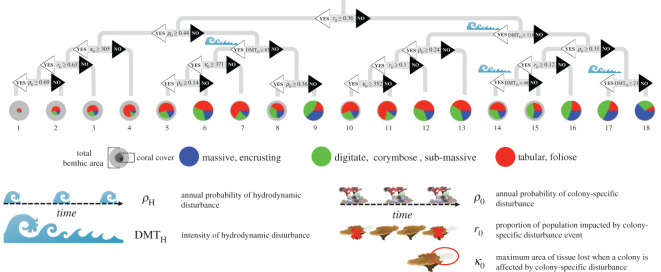
Summary of outputs from a multivariate regression tree analysis, summarizing the structuring of 100 000 simulations across ranges of five disturbance parameters. A total of 17 parameter conditions result in 18 stereotypical coral communities. Range of parameter values explored are presented in table 1. Each parameter condition presented here is hierarchical, structured as a decision tree with parameter inequality noted in the break, agreement with inequality labelled with a white arrow (and text ‘YES’, always linked to following tree to the left), and disagreement labelled with a black arrow (and text ‘NO’, always linked to following tree to the right). Only four parameter conditions in the final tree are dependent on hydrodynamic parameters, and each is labelled with an inset outline of disturbance icon. Stereotypical assemblages are the mean composition of the coral assemblage over 500 years of simulation and are represented by a pie chart with wedge colour corresponding to the proportion of each coral morphological group (tabular/foliose in red; digitate/corymbose/sub-massive in green and the encrusting/massive in blue); the size of the inner coloured circle represents the total coral area relative to total benthic area (light grey background circle) available to coral recruitment and growth.